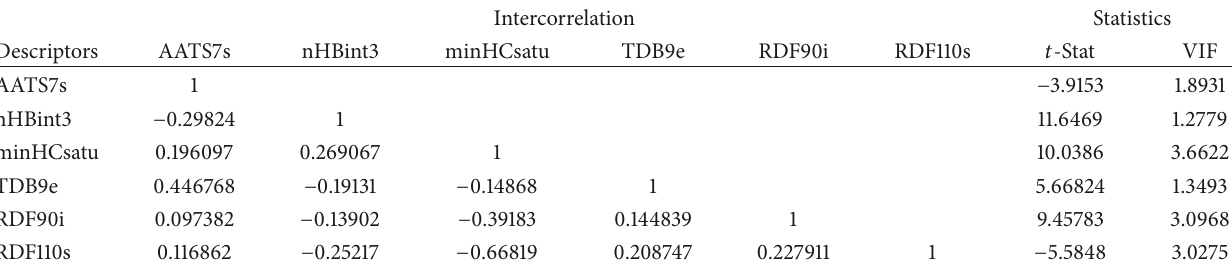
Table 7: Pearson’s correlation matrix and statistics for descriptor used in the QSAR optimization model.